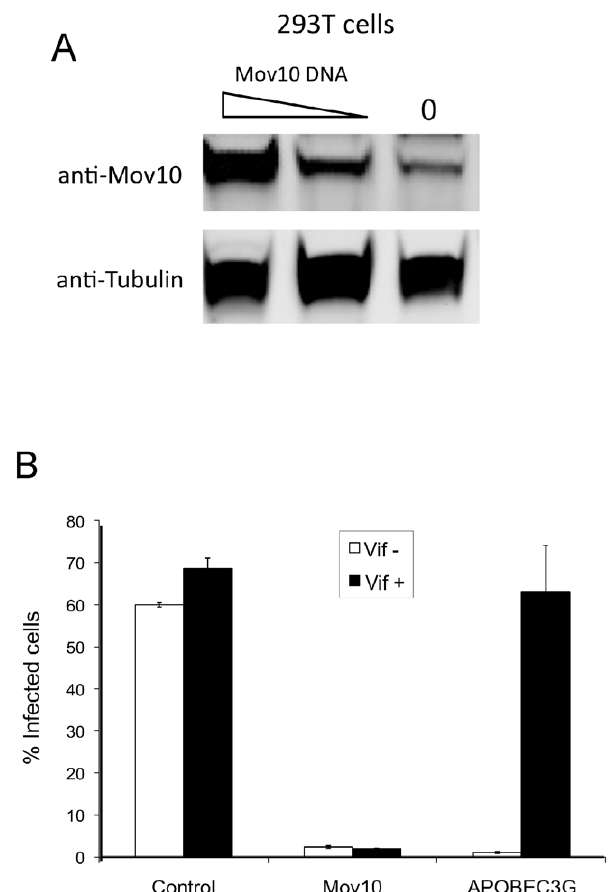
Figure 1. Overexpression of Mov10 decreases HIV-1 infectivity. ( A ) 293T cells were transfected with different amounts of Mov10 plasmid, and the expression of Mov10 was determined by Western blot. ( B ) 293T cells were transfected with 0.5 m g of either pCMV6-XL5 plasmid (control), Mov10 or APOBEC3G in the presence or absence of 0.5 m g vif as well as 1 m g HIV-1-GFP ( D env, D vif, D vpr, D nef) and 0.5 m g p-L-VSV-G. Virus was collected 24 h later, and then added to Jurkat T cells. Virus transfer was standardized across treatment conditions by p24 levels as described (Materials and Methods). Percent infected cells was then determined using FACS analysis for GFP-expression after virus was allowed to incubate with target cells for 72 hours. Error bars represent one standard